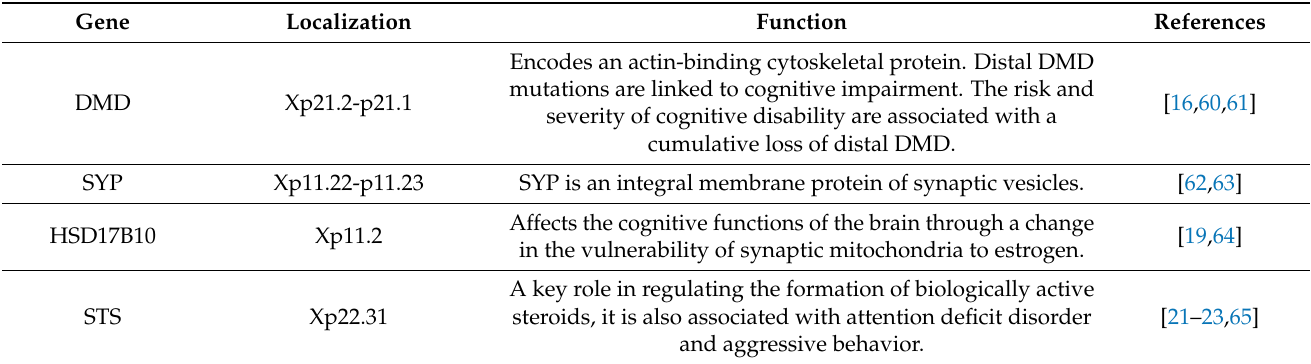
Table 1. Function and localization of sex chromosome genes that are essential for brain